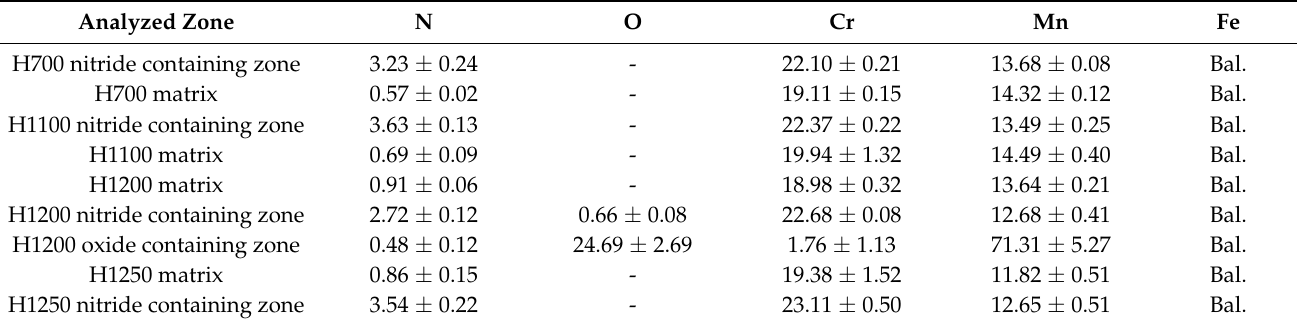
Table 5. The EDS results of as-fabricated porous samples reduced by H 2 ,